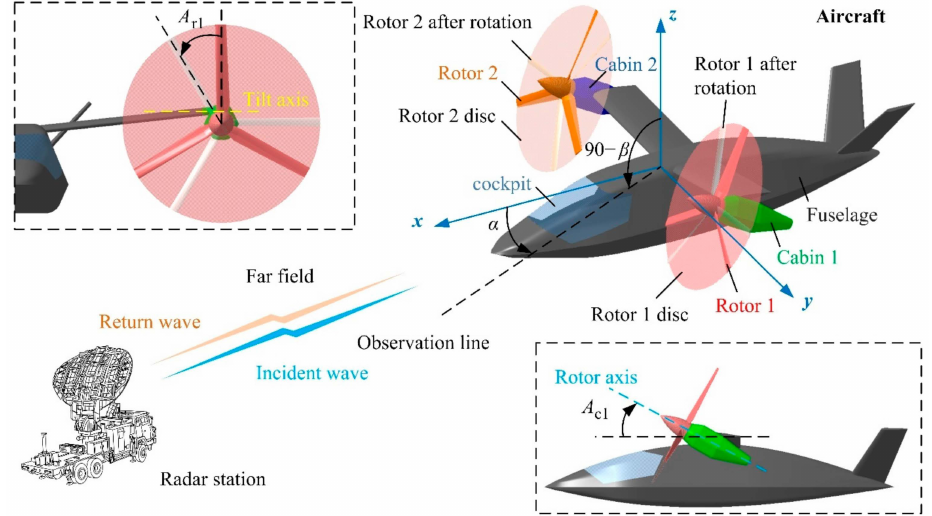
Figure 1. Schematic of dynamic electromagnetic scattering of tilt rotor